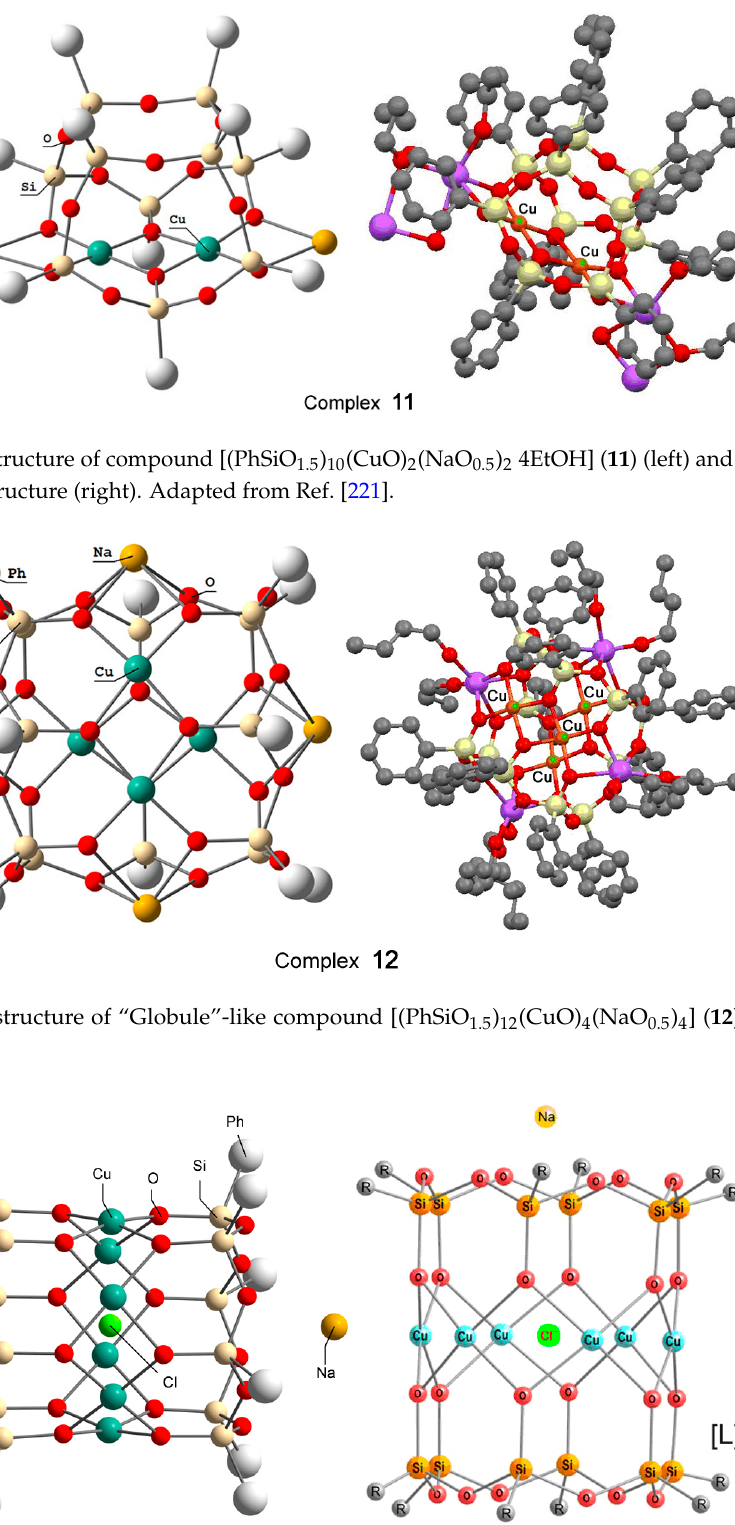
Figure 7. The structure of hexanuclear cylinder ‐ like copper silsesquioxane [(PhSiO 1.5 ) 12 (CuO) 6 (NaCl)(C 4 H 8 O 2 ) 12 (H 2 O) 2 ] ( 13 ), L = 1,4 ‐ dioxane/H 2 O. Adapted from Ref. [223].